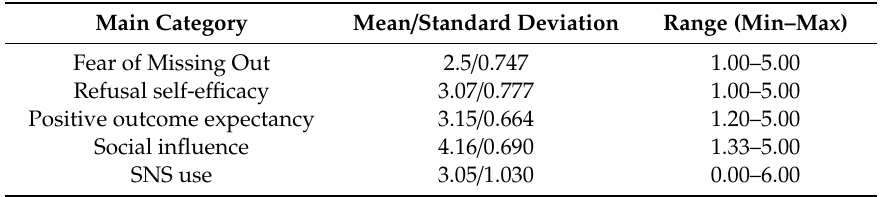
Table 2. The distributions of main